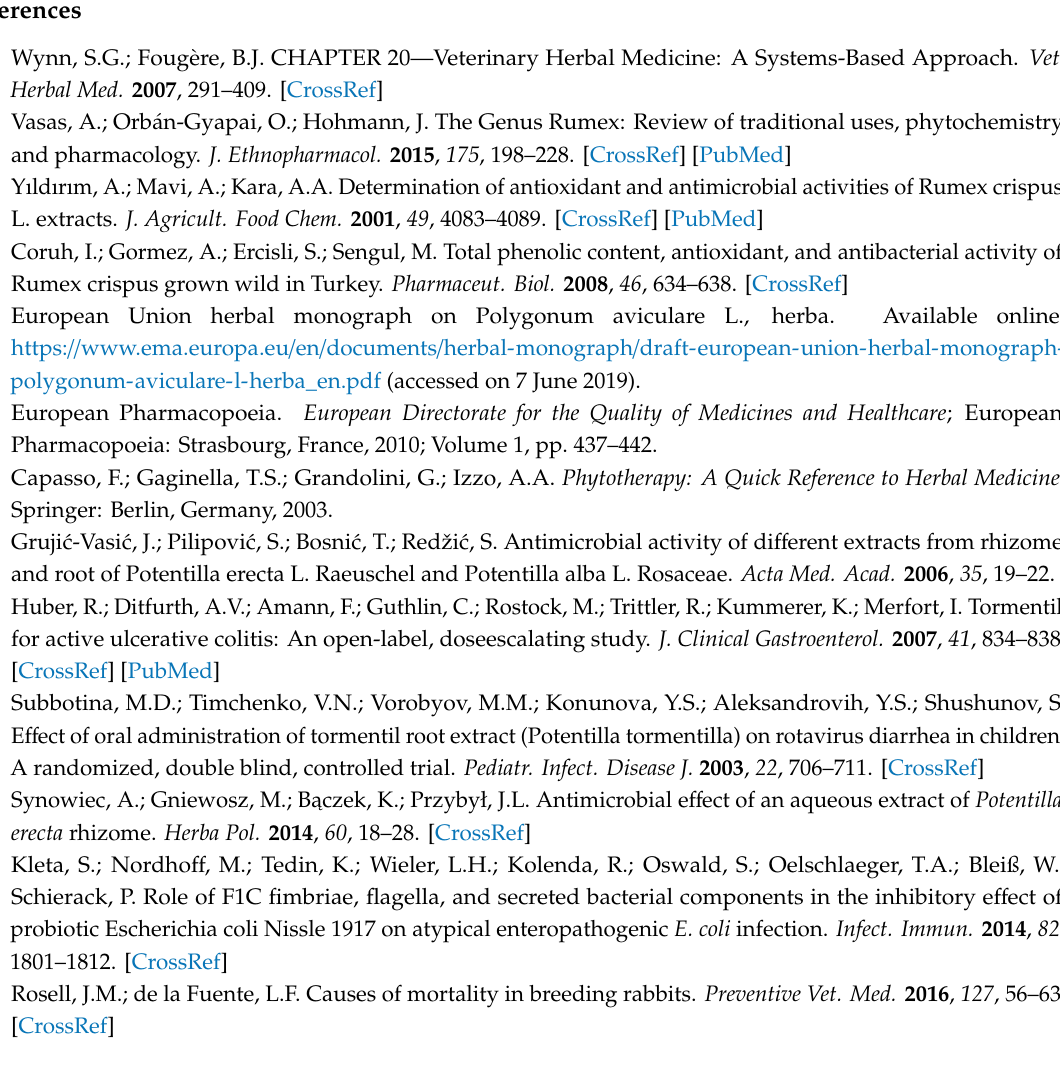
Table S1: Profile and content of Rumex inflorescence fatty acids, Table S2: GC-MS profile and content of Rumex polar